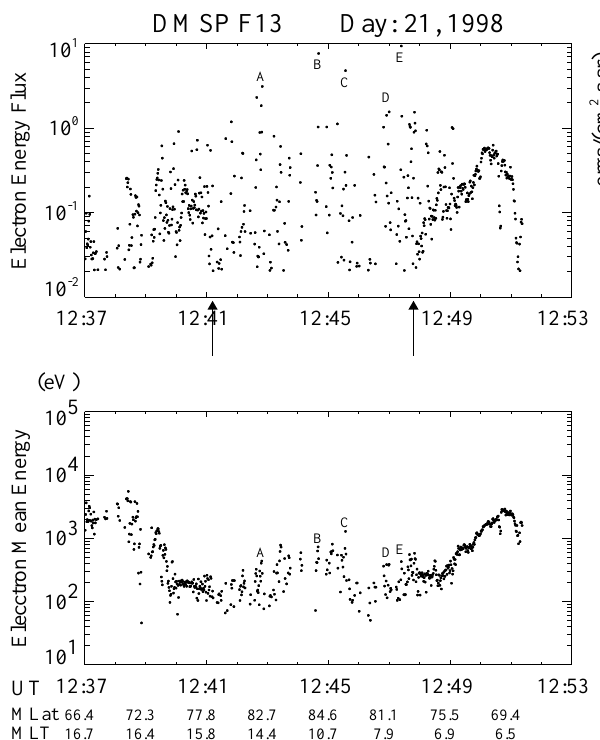
Fig. 10. Electron flux and energy plots similar to Fig. 8, but from a DMSP F13 pass from 1237 to 1253 UT on January 21, 1998